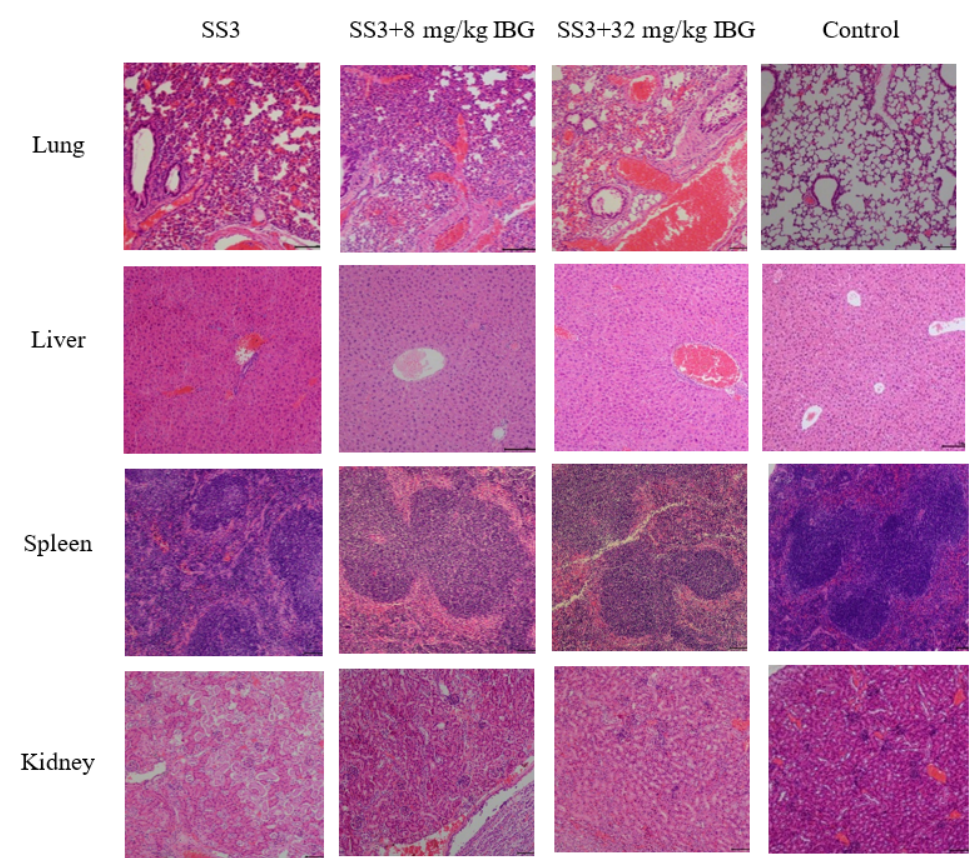
Figure 6. Histologic analysis of different organs using hematoxylin-eosin (HE) staining. Patholog- ical changes in lung, liver, spleen, and kidney histology after IBG treatment. IBG alleviated the pathological damage and inflammatory response in infected